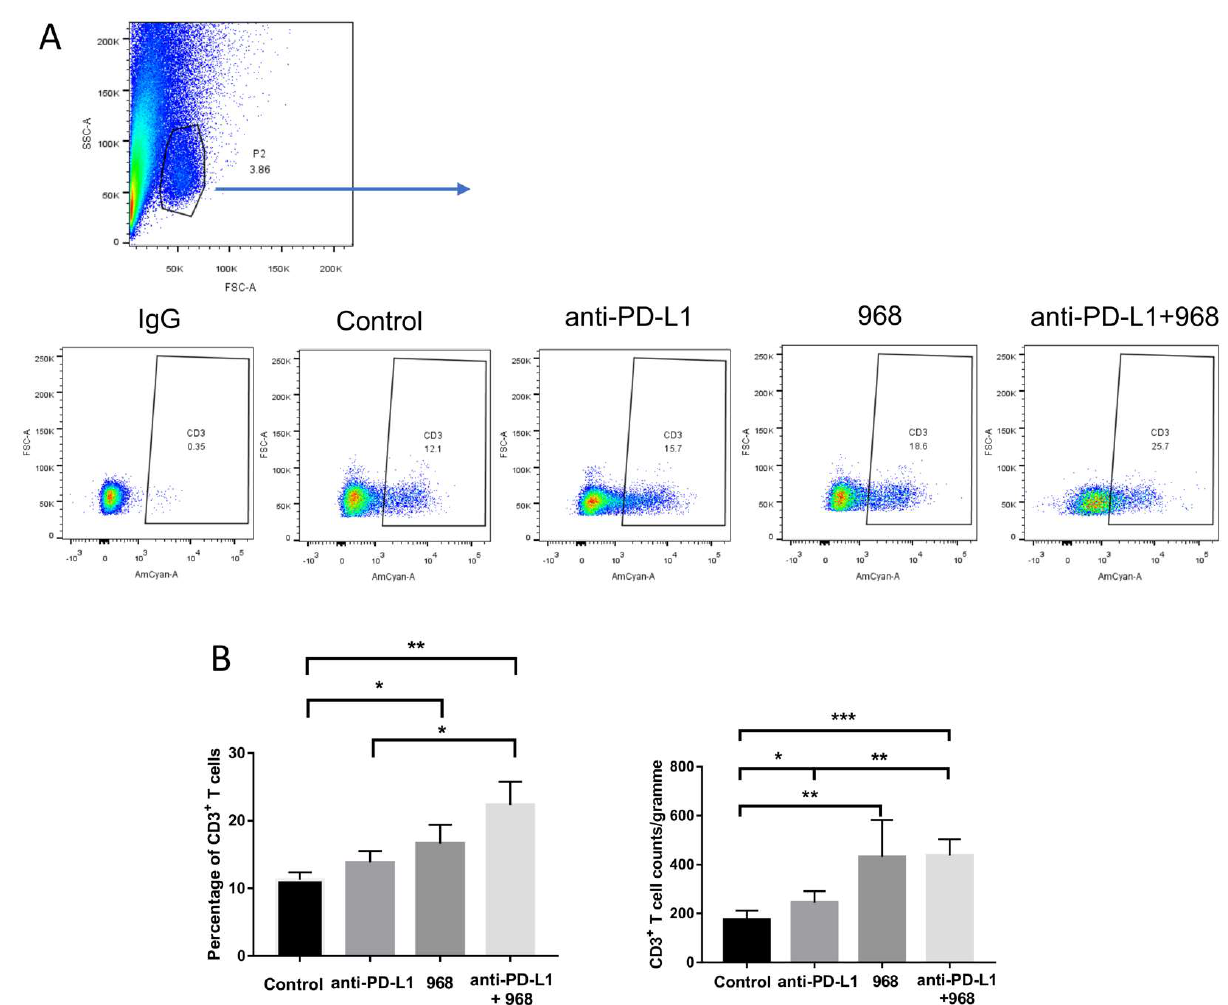
Figure 6. The combination of glutaminase inhibitor 968 with anti–PD–L1 antibody enhanced the infiltration of CD3 + T cells into tumors. ( A ) Representative results of CD3 + T cells infiltrated into tumors. ( B ) Statistical analysis of CD3 + T cells that infiltrated into tumors from the four groups (* p < 0.05, ** p < 0.01).